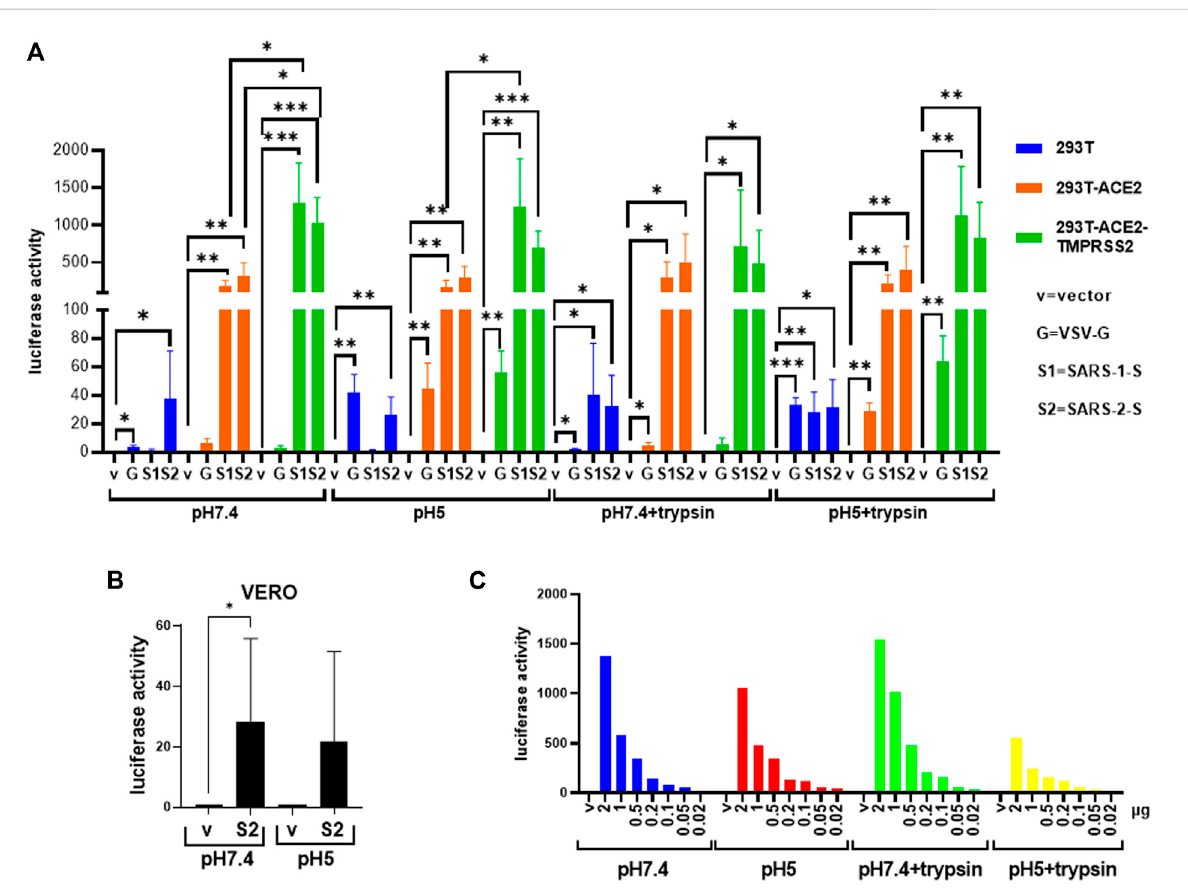
FIGURE 3 Severe acute respiratory syndrome coronavirus 2 spike protein triggers fusion in different cell types and fusion conditions. (A,B) Donor 293Tcellsweretransfectedwithemptyvector(negativecontrol)orthesevereacuterespiratorysyndromecoronavirus1and2spikeproteins (SARS- 1-S, SARS-2-S), respectively together with a plasmid encoding the T7 polymerase. 19,000 donor cells were co-cultured with 19,000 target cells (A) (293T,293T-ACE2,293T-ACE2-TMPRSS2)or (B) Verocellstransfectedwiththeluciferaseand β -galactosidasereportergenes.Theco-cultures were treated as indicated. Fusion activity was measured as luciferase activity normalized against β -galactosidase activity and expressed as a ratio to their respective vector control in the respective cell type and fusion condition. Data on the vesicular stomatitis virus glycoprotein (VSV-G) from Figure 2A are included for comparison purpose. Data are presented as mean +/ − SD of 3 repeats. (C) Donor 293T cells transfected with an empty vector or serial doses of the plasmid expressing the SARS-2-S, as indicated, were co-cultured with target 293T-ACE2 cells under various